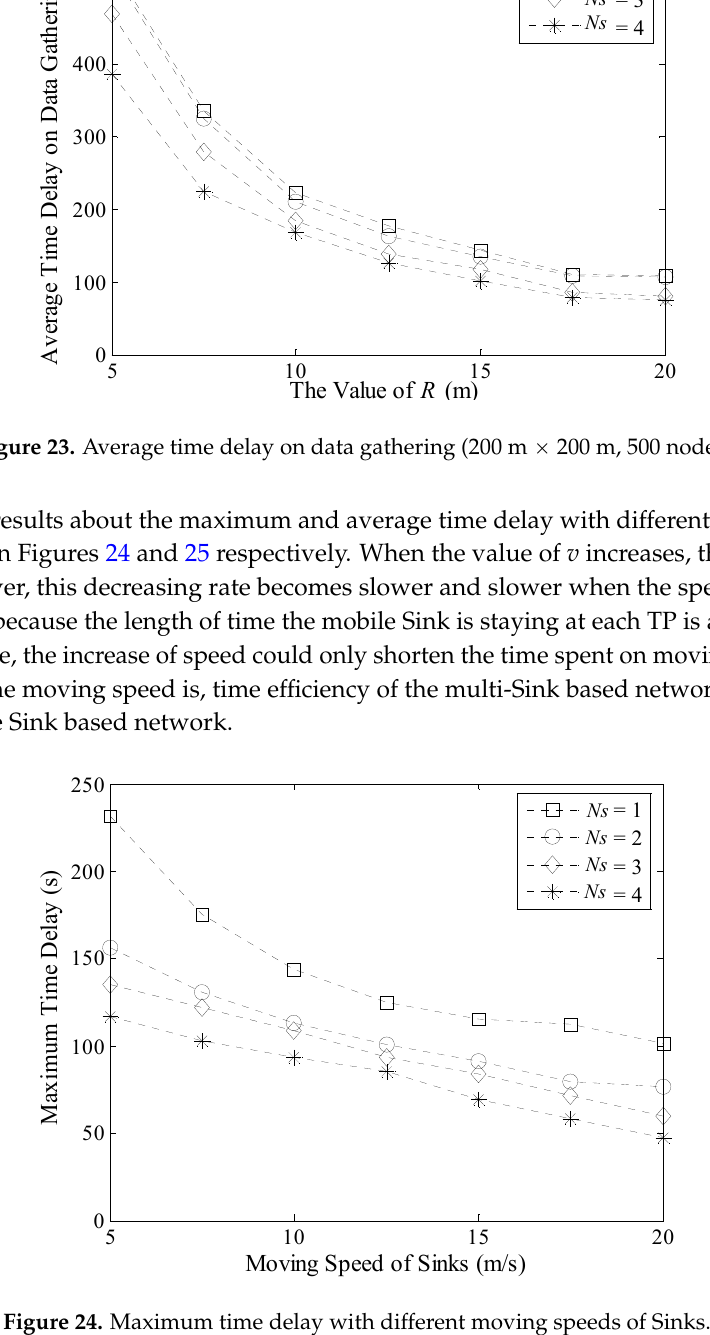
Figure 22. Maximum time delay on data gathering (200 m × 200 m, 500 nodes).